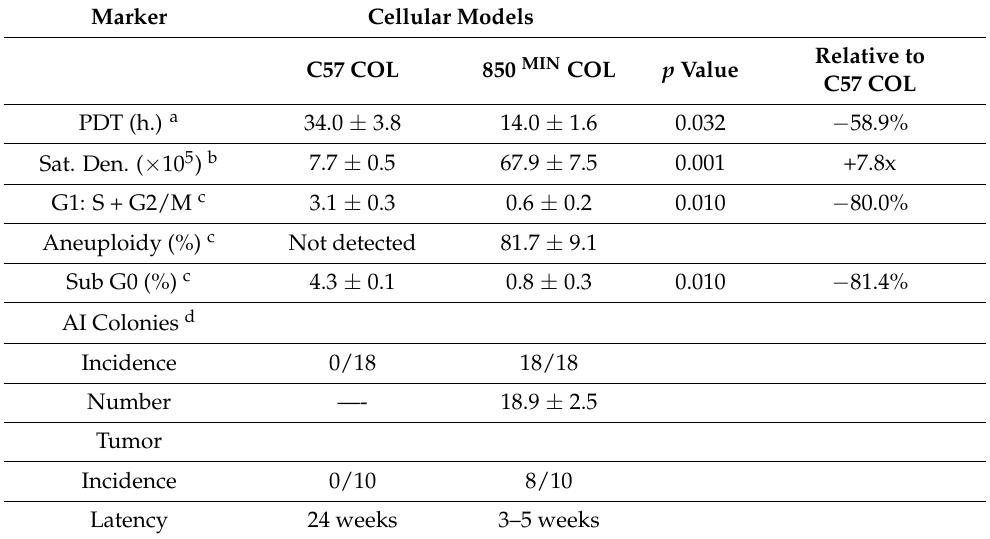
Table 3. Hyper-proliferation and carcinogenesis in 850 MIN COL